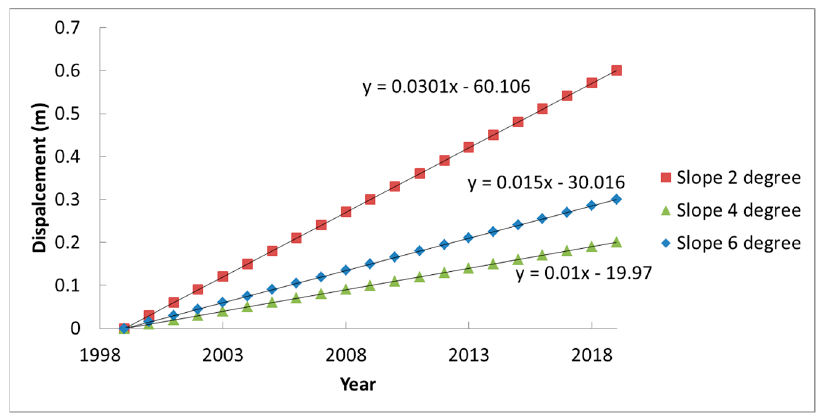
Figure 16. Horizontal displacements obtained following a geometric steady-state approach: sea-level rise determines a landward shoreline movement without accretion, where the shoreline rate change is dependent only on the coastal slope. Table 1. Effective shoreline rate changes between 1999 and 2020 in the Gulf of Taranto, corrected with geometric horizontal migration rates.